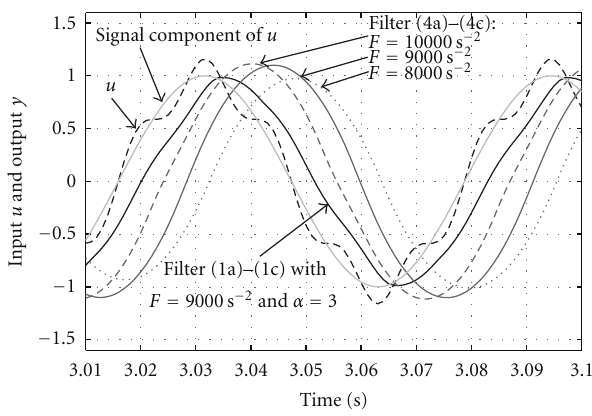
Figure 12: Comparison between the outputs of filter (1a)–(1c) with F = 9000s − 2 and α = 3 and filter (4a)–(4c) with F = 8000, 9000, and 10000s − 2 for the input u = sin(100 t ) + 0 . 16 sin(500 t ).